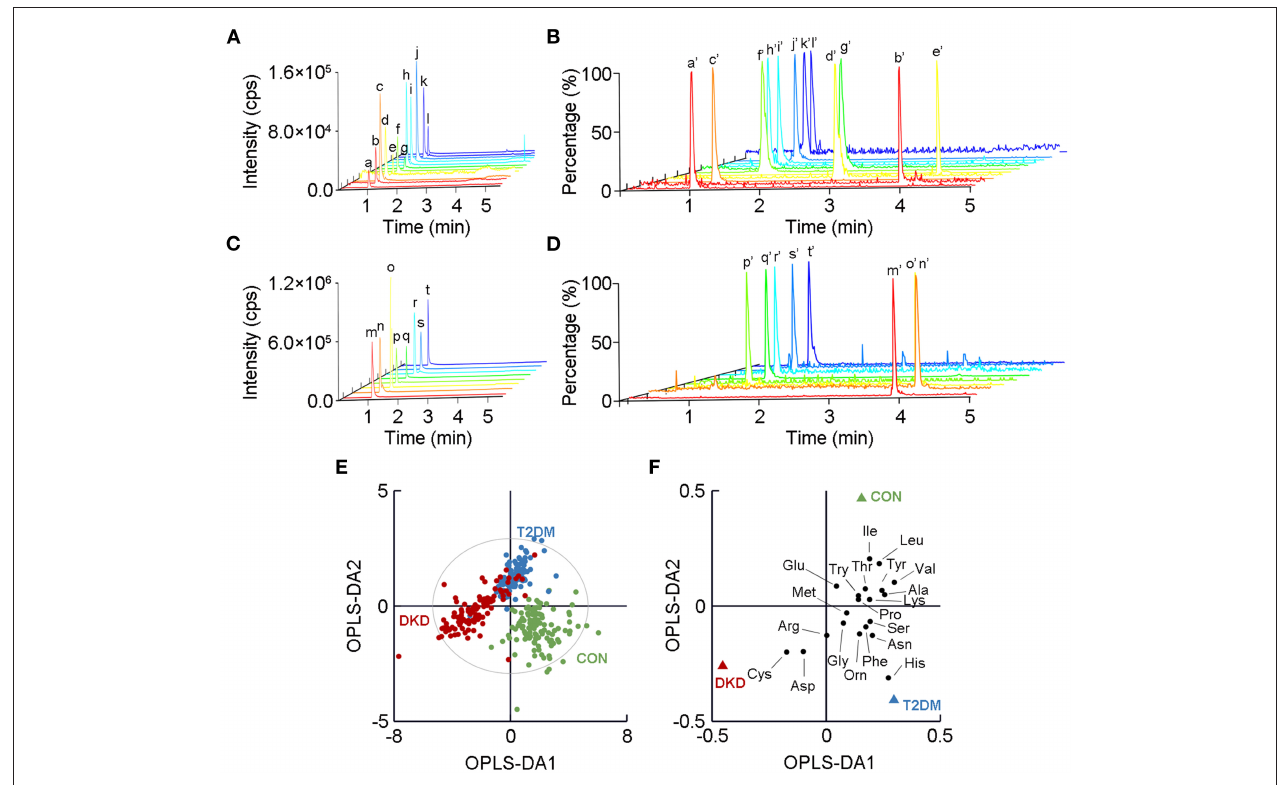
FIGURE 1 | Metabolomic profiles of the 20 amino acids (AAs) in plasma in the DKD group, T2DM group, and CON group. A chromatogram of (A) low-response AAs and (B) their corresponding isotope-labeled internal standards (ISs) detected by ultra-performance liquid chromatography tandem mass spectrometry. A chromatogram of (C) high-response AAs and (D) their corresponding isotope-labeled ISs. a to t show mass-spectrometry plots for the 20 AAs, while a’ to t’ show the corresponding isotope-labeled ISs. Detailed information relating to a to t and a’ to t’ is listed in Supplementary Tables 1 , 2 . (E) Orthogonal partial-least-squares discriminant analysis (OPLS-DA) score plot shows the visual separation of the DKD group, T2DM group, and CON group. The ellipse indicates the Hotelling T2 (0.95) range for the model. (F) Loading plot analysis showing the relative contributions of the 20 AAs to the differences between the DKD, T2DM, and CON groups. DKD, diabetic kidney disease; T2DM, type 2 diabetes mellitus; CON, healthy control.